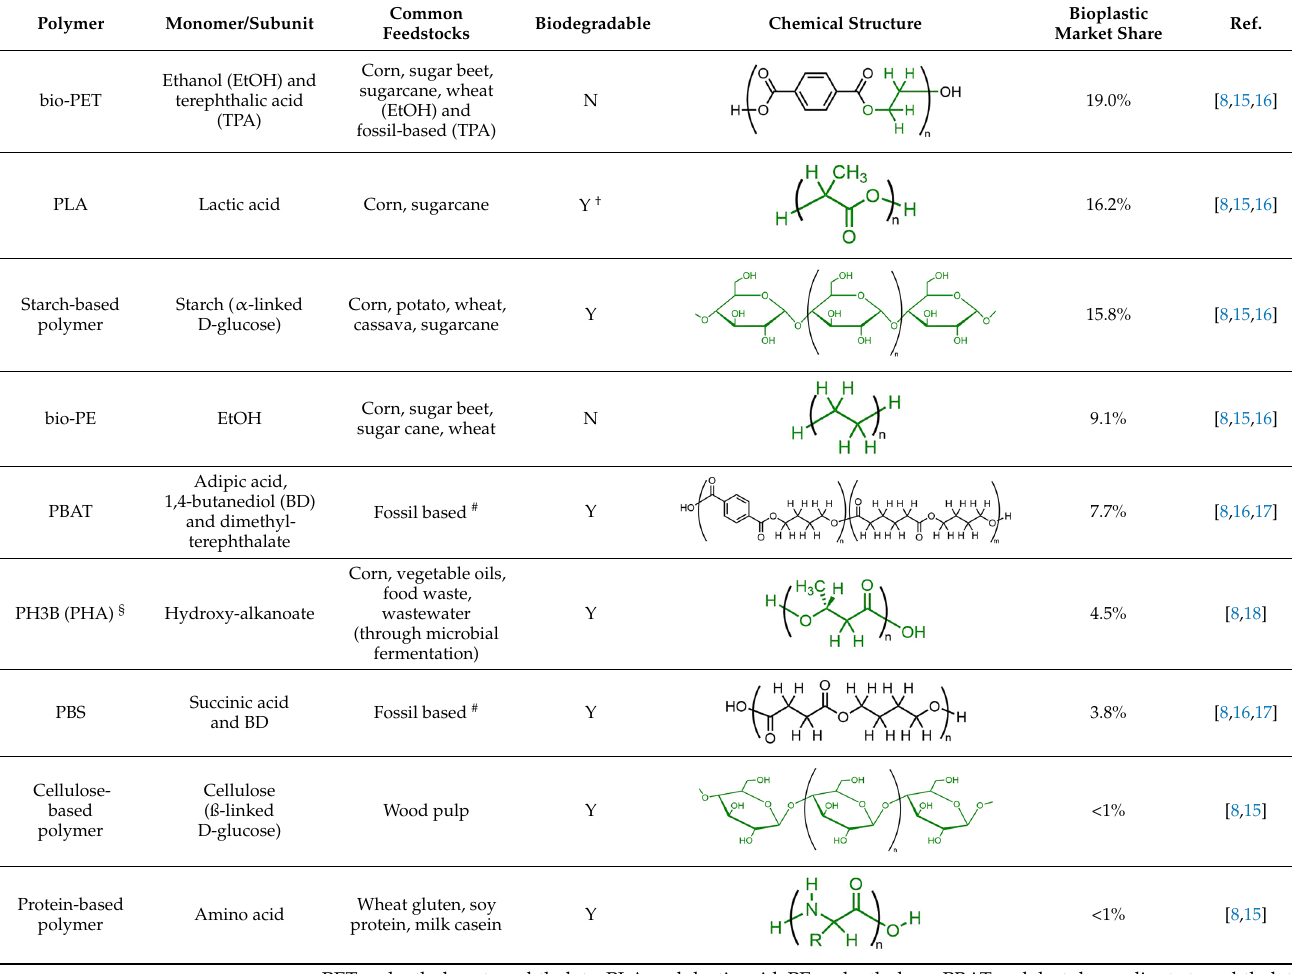
Table 1. Most common industrially produced